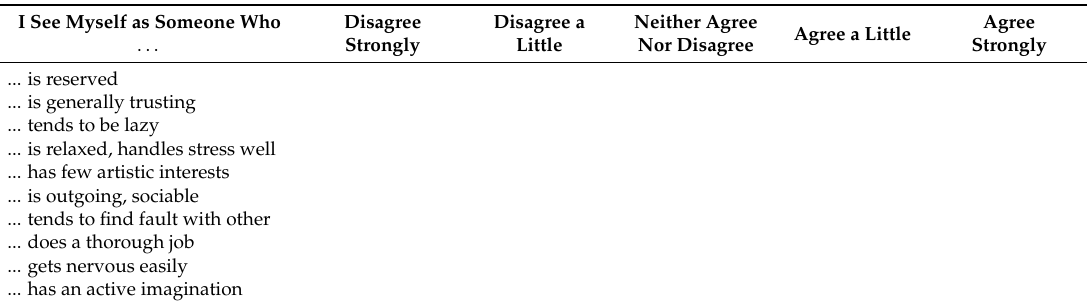
Table A2. BFI-10 English